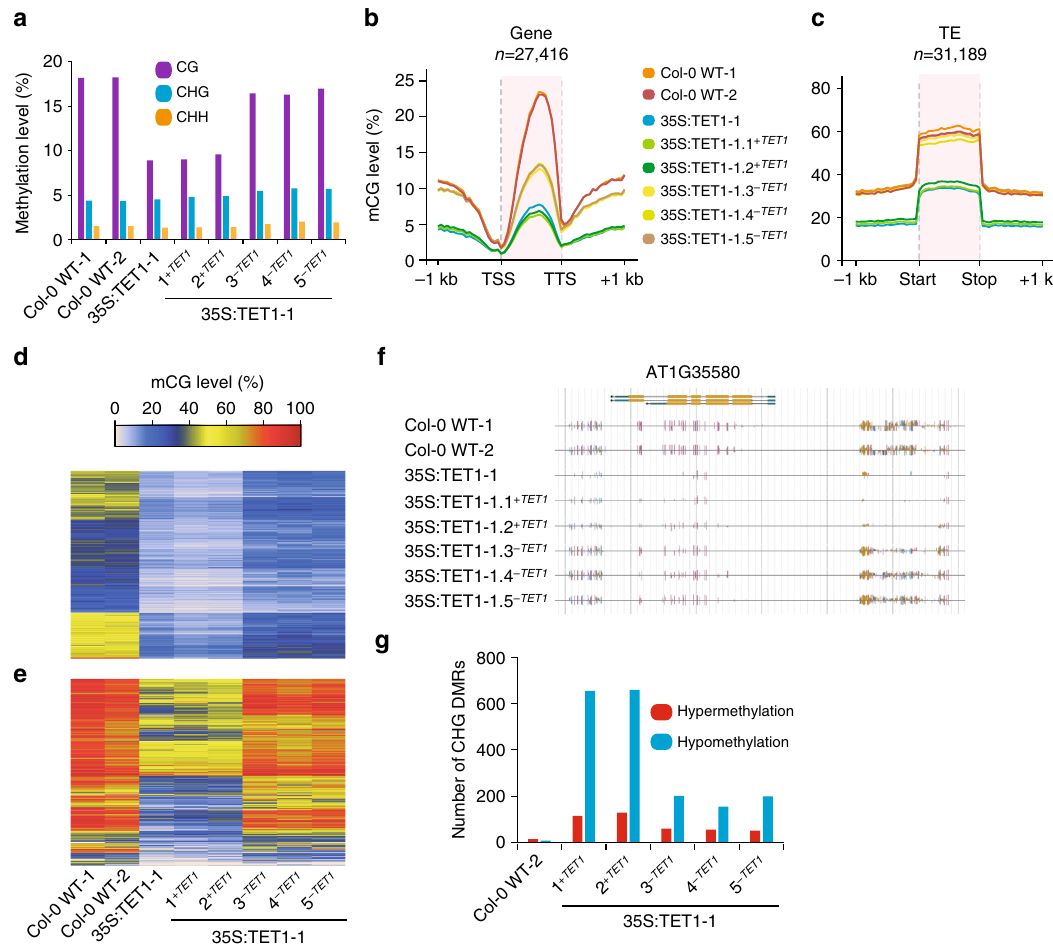
Fig. 4 Transgenerational demethylation pro fi le of 35S:TET1 individuals. a Bar plots of global methylation levels in two Col-0 WT replicates and 35S:TET1-1 plants. Metagene plots of mCG level across b gene bodies and c transposable elements. Heat map of mCG level of d all gbM genes and e transposable elements with >20% mCG in wild type. f Genome browser view of a methylome pro fi le of a representative region of the A. thaliana genome in 35S:TET1-1 individuals. g Number of identi fi ed CHG DMRs in 35S:TET1 T2 plants. These DMRs were de fi ned relative to Col-0 WT-1, as Col-0 WT-2 DMRs were used to assess superfolder GFP (sfGFP) hTET1cd fusion, under control of the A. thaliana ACTIN 2 (ACT2) promoter (ACT2:sfGFP-hTET1cd),